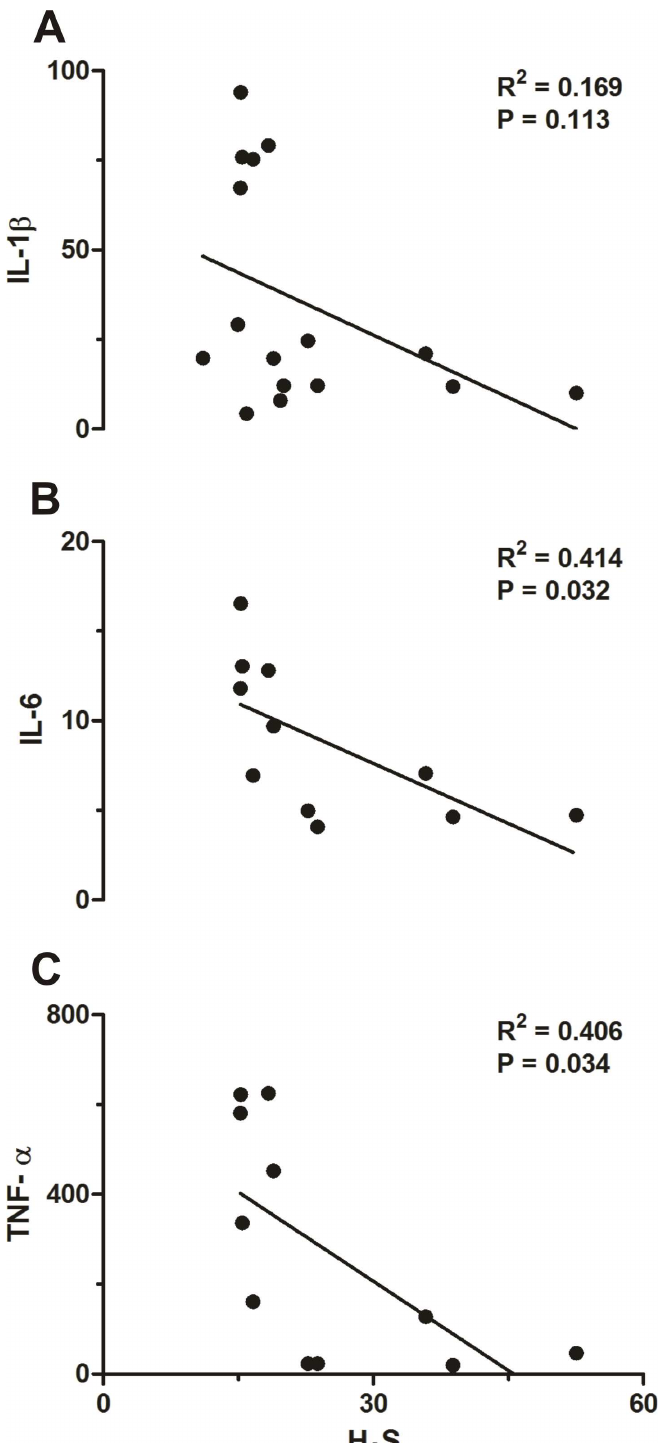
Fig 5. Correlation analyses between H 2 S and IL-1 β (A), IL-6 (B) and TNF- α